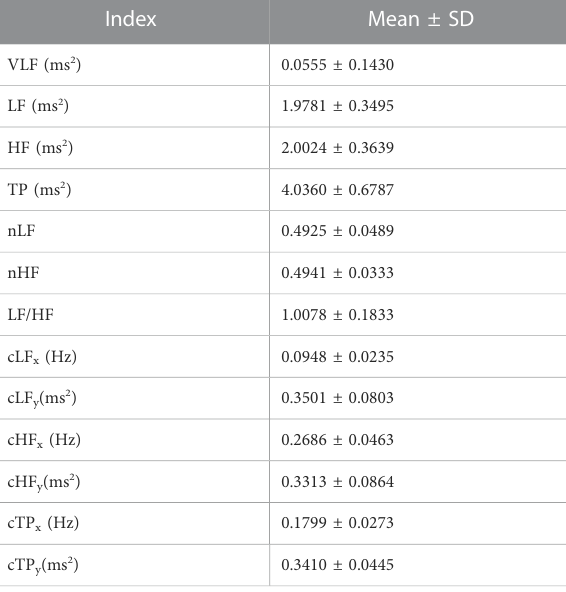
TABLE3Meanandstandarddeviation(SD)valuesforPRVindicesextracted from gold standard